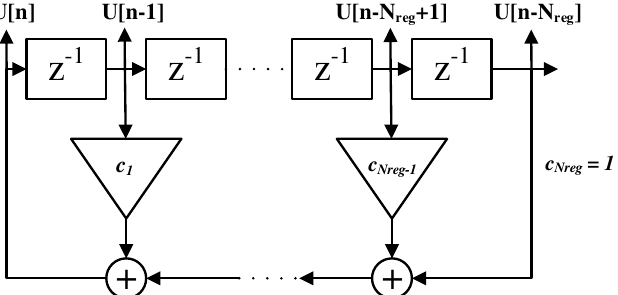
Figure 2. Basic linear feedback shift registers (LFSR) schematic. The blocks indicated with z − 1 represent time shifts of a single